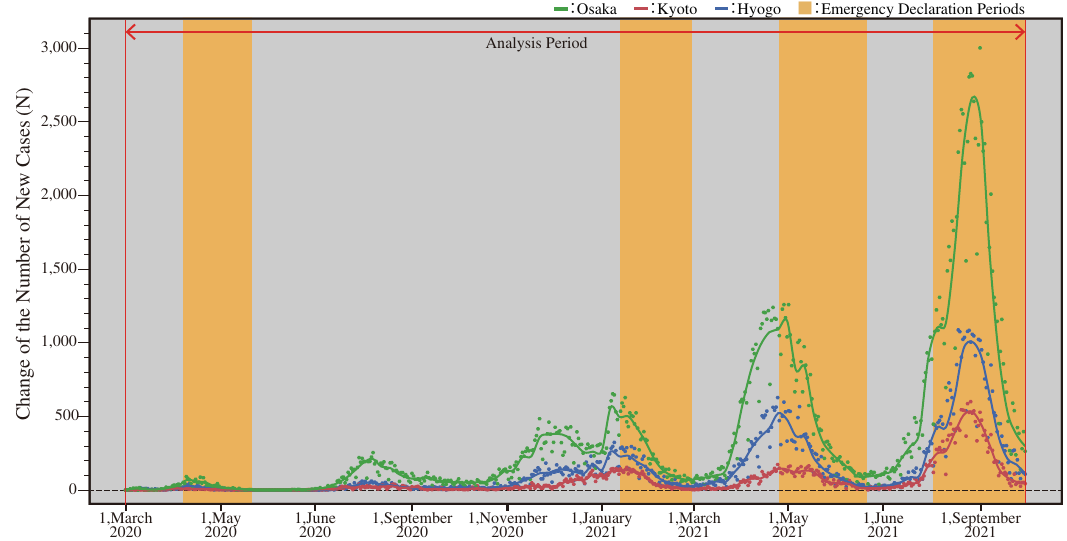
Fig. 3 Change in the number of COVID-19 cases. Green points and line are the data of Osaka Prefecture, red points and line are the data of Kyoto Prefecture, and blue points and line are the data of Hyogo Prefecture.